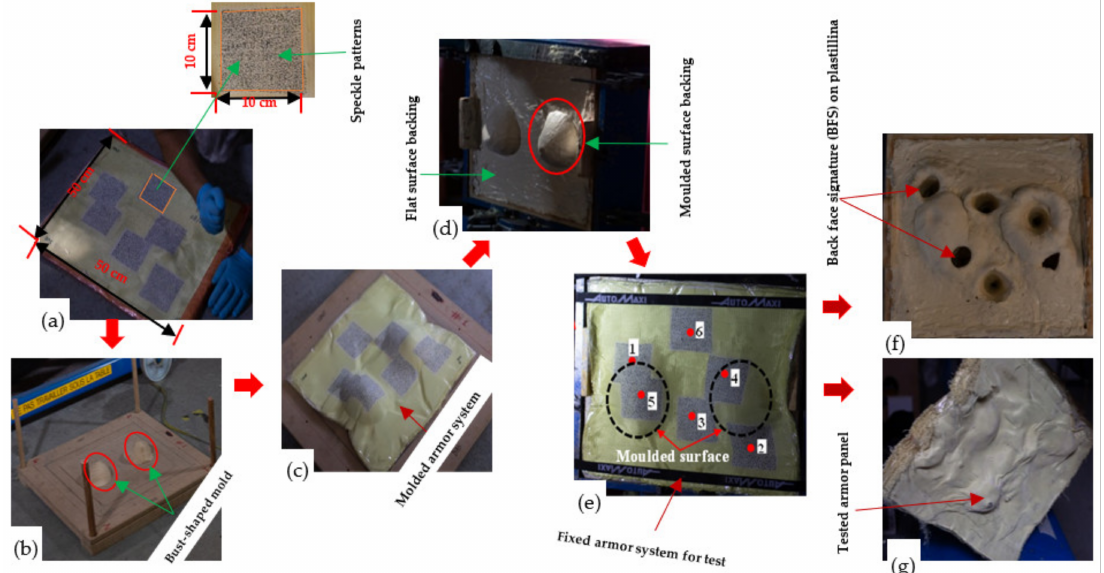
Figure 2. Armour panel system preparation before testing and after testing: ( a ) nondeformed aligned armour system with random speckle pattern; ( b ) customized forming equipment; ( c ) molded armour panels to resemble frontal women morphology; ( d ) prepared backing material (plastillina) with inverted women frontal form; ( e ) armour panels ready for the test based on NIJ-Level IIIA; ( f ) backing panels with deformation after the test and ( g ) back view of the tested armour